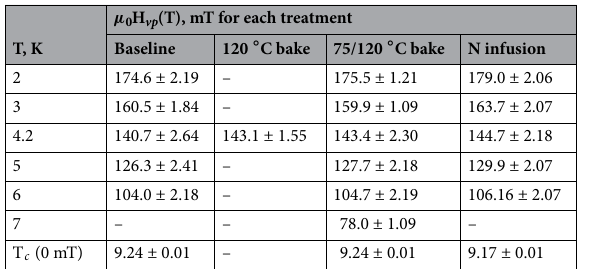
Table 1. The field of full flux penetration for each set temperature and the critical temperature determined by using the linear dependence of H vp vs T